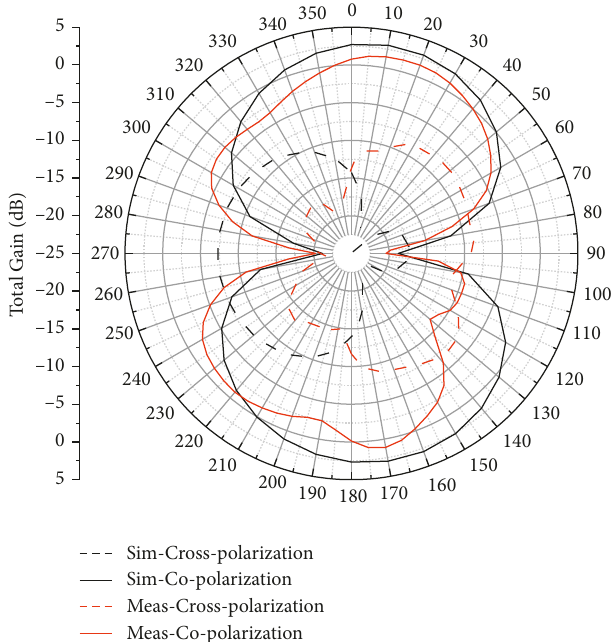
Figure 15: Radiation E plane of the proposed